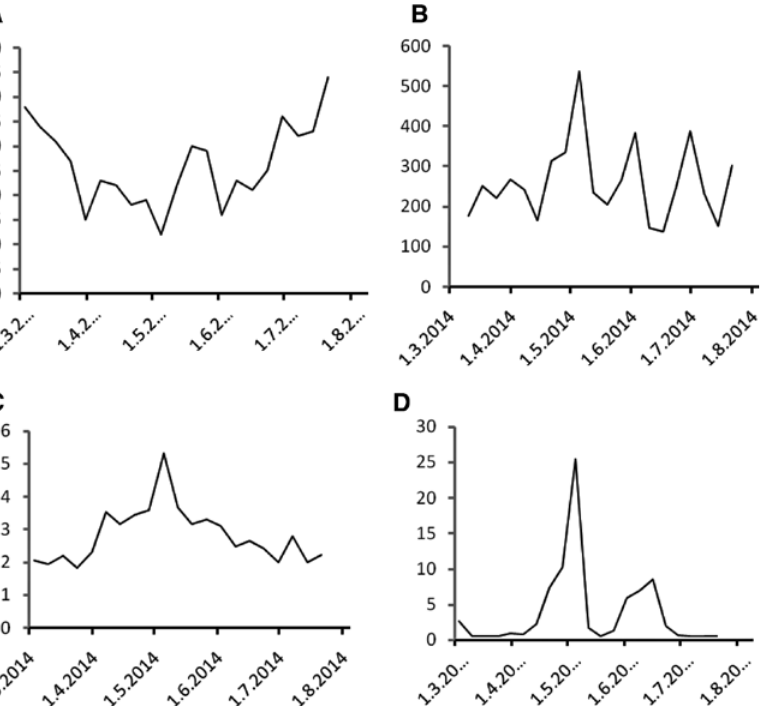
Figure 1: Citrulline, neopterin and C-reactive protein during the course of treatment. (A) Plasma citrulline (in μ mol/L), (B) urinary neopterin (in μ mol/mol creatinine), (C) serum neopterin (in μ g/L) and (D) C-reactive protein (in mg/L) concentrations measured in weekly intervals during the course of